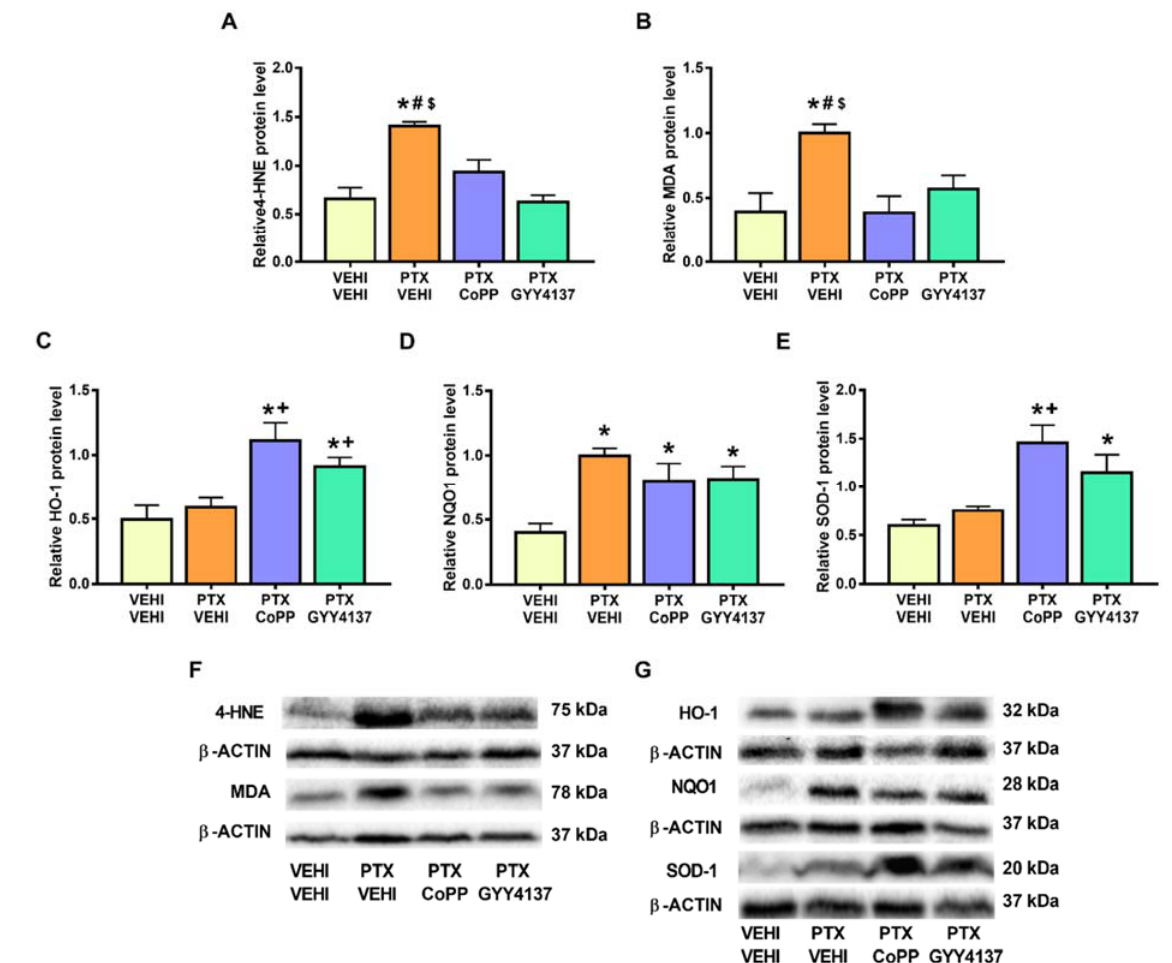
Figure 9. Effects of CoPP and GYY4137 on the levels of 4-HNE, MDA, HO-1, NQO1, and SOD1 in the DRG of PTX-injected mice. Graphs represent the levels of 4-HNE ( A ), MDA ( B ), HO-1 ( C ), NQO1 ( D ), and SOD-1 ( E ) in the DRG of PTX-injected animals treated with CoPP or GYY4137. The control group treated with VEHI–VEHI is also represented. Representative blots for 4-HNE and MDA ( F ) and for HO-1, NQO1, and SOD1 ( G ) are shown. All proteins are represented relative to β -actin levels. In all panels, * indicates significant differences vs. the VEHI–VEHI-treated mice; +, vs. animals treated with PTX–VEHI; #, vs. the PTX–CoPP-treated mice; and $, vs. mice treated with PTX plus GYY4137 ( p < 0.05, one-way ANOVA followed by the SNK post hoc test). Data are expressed as mean values ± SEM; n = 3 samples per group.